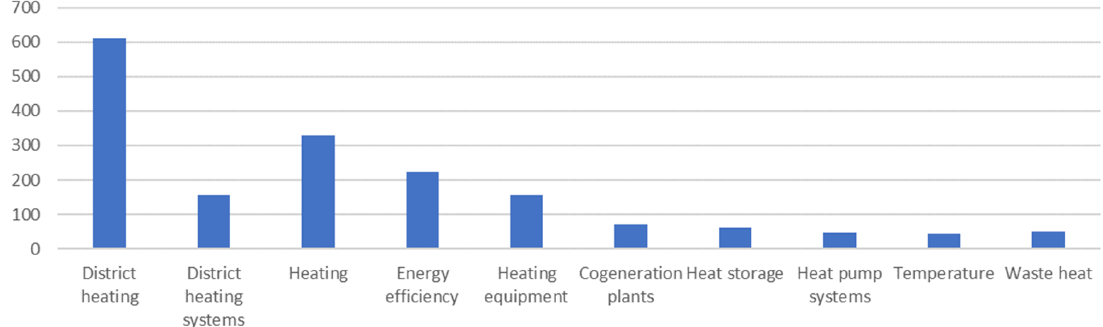
Figure 17. All groups—most frequent keywords (horizontal axis) and the number of articles (vertical axis).